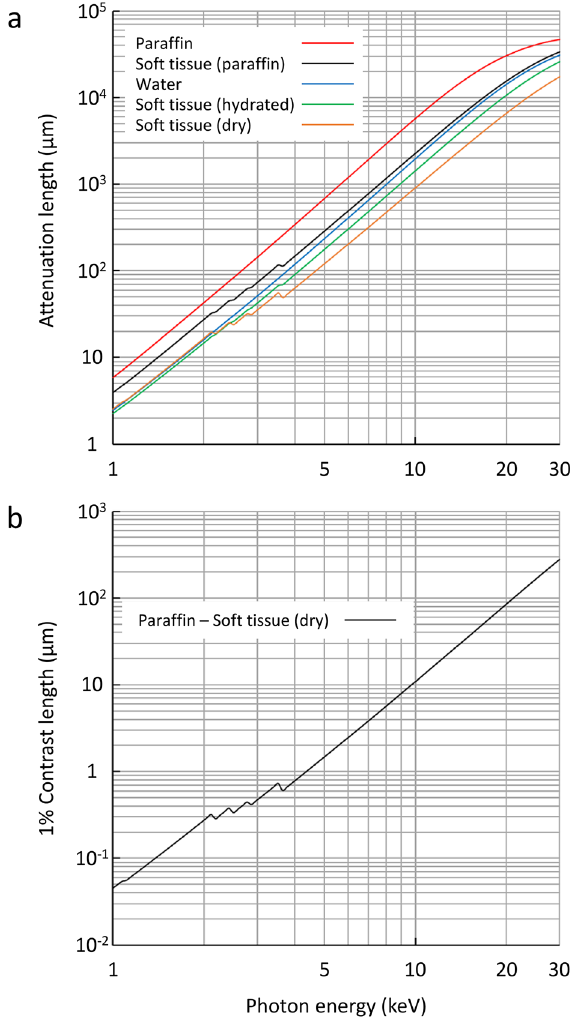
Figure 1. Curves of X-ray absorption versus photon energy. ( a ) X-ray attenuation length in μm. Color codes used were: red for paraffin (A p ), black for paraffin-embedded soft tissue (A pt ), blue for water (A w ), green for hydrated soft tissue (A ht ), and orange for dehydrated (dry) soft tissue (A dt ). Gain in the medium:sample ratio of attenuation length upon the medium replacement from water to paraffin can be calculated as (A p /A dt )/(A w / A dt ) = A p /A w when A w ≥ A dt , or (A p /A dt )/(A dt /A w ) when A w < A dt . Water content by weight, volumetric mass density, and elemental composition for the hydrated soft-tissue (without adipose tissue) were taken from literature 37 as 70%, 1.06, and H 10.2 C 14.3 N 3.4 O 70.8 Na 0.2 P 0.3 S 0.3 Cl 0.2 K 0.3 , respectively, which were used to calculate density and elemental composition for the dehydrated soft-tissue as 1.23 and H 8.1 C 47.6 N 11.3 O 28.6 Na 0.7 P 1 S 1 Cl 0.7 K 1 , respectively. Similarly, density and elemental composition for the paraffin-embedded soft-tissue were calculated as 0.99 (0.986) and H 5.3 C 80.4 N 3.7 O 9.3 Na 0.2 P 0.3 S 0.3 Cl 0.2 K 0.3 , respectively. Attenuation length was calculated from density and elemental composition using a web tool (https:// henke. lbl. gov/ optic al_ const ants/ atten2. html) 38 ; densities for paraffin (H 1 C 2 ) and water (H 2 O 1 ) were set as 0.90 and 1.00, respectively. ( b ) 1% Contrast length in μm. Length giving 1% difference in X-ray transmission between paraffin and dehydrated soft tissue was calculated as A p × A dt × ln(0.99)/(A dt -A p